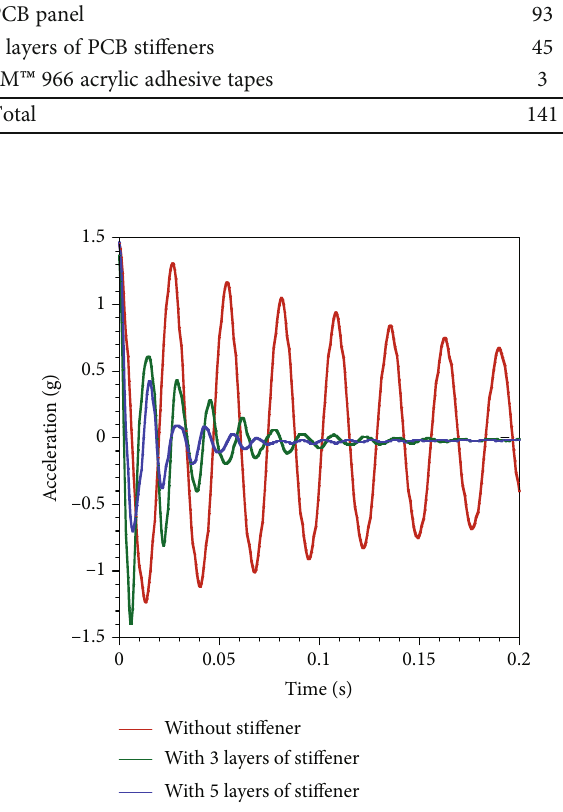
Figure 3: Free-vibration test results of the solar panels with various numbers of sti ff eners.